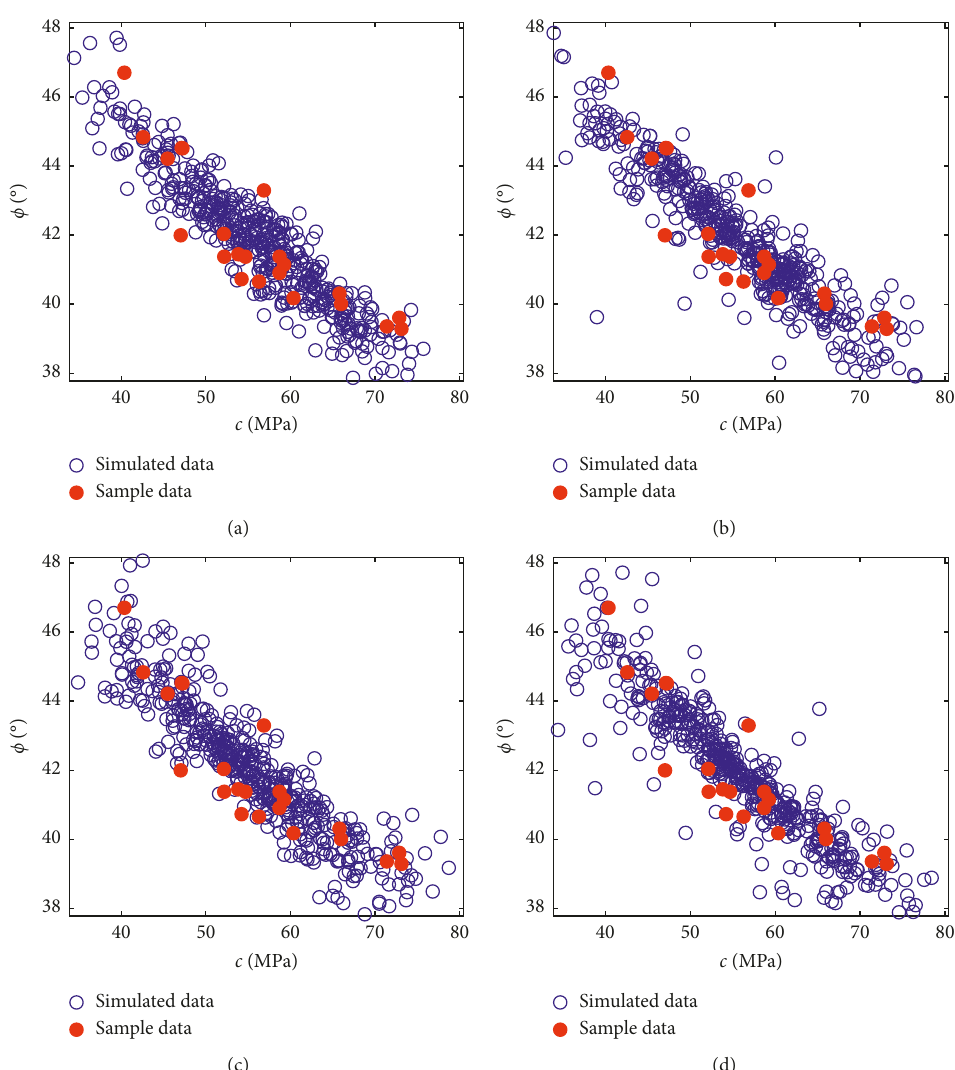
Figure 10: Scatter plots of equivalent samples generated by different copulas coupling Truncnormal margins. (a) Gaussian copula. (b) Plackett copula. (c) Frank copula. (d) No. 16